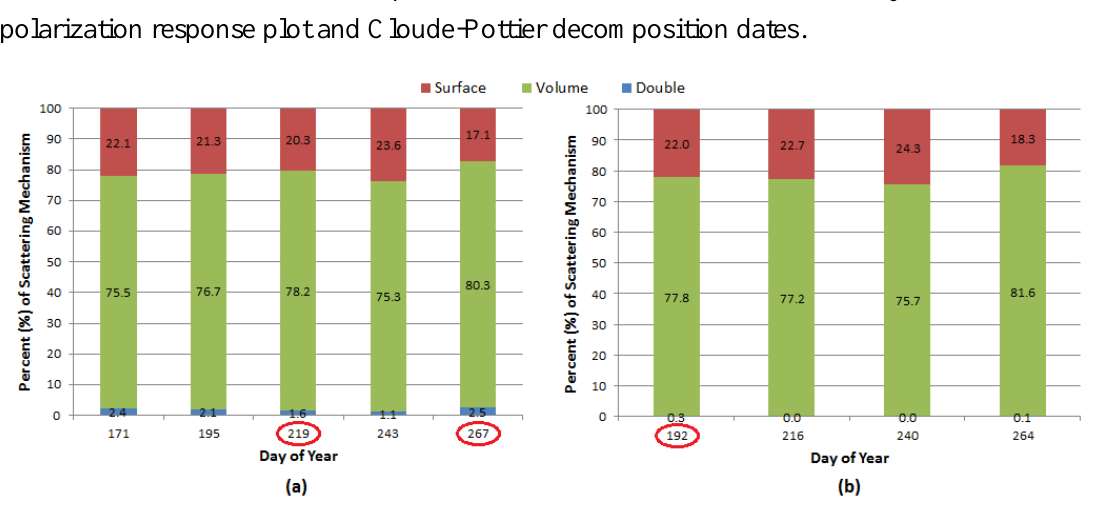
Figure 9. Urban co- (Left) and cross-polarization (Right) polarimetric response plots based on RADARSAT-2 fine-quad beam modes for 20 June ( a , b ); 4 August ( c , d ); and 21 September ( e , f